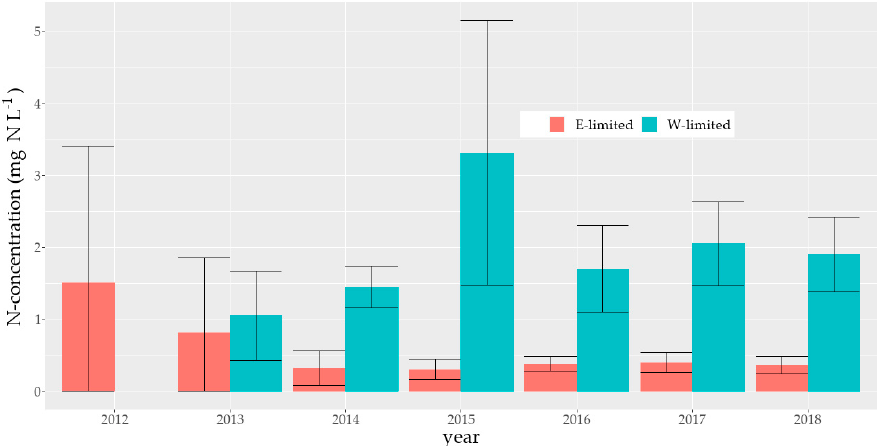
Figure 8. Mean and confidence interval (95% confidence level) of nitrogen concentration (mg N L − 1 ) in the drained water per year for the Rollesbroich soil in Rollesbroich, the energy-limited site (E-limited) and Selhausen, the water-limited site (W-limited). No observations of N-concentration were available for Selhausen in 2012. The confidence intervals per study site were calculated from